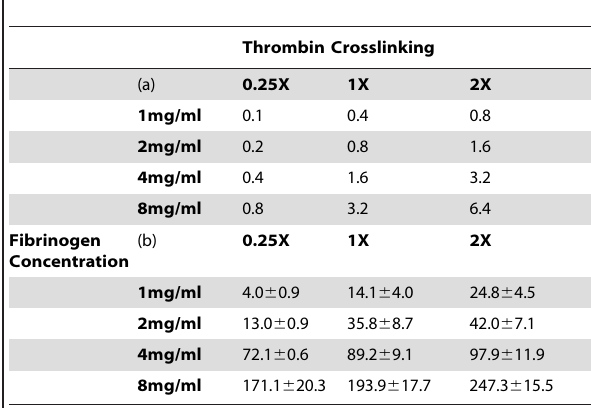
Table 1. Fibrinogen and thrombin concentration used to synthesize the gel and corresponding